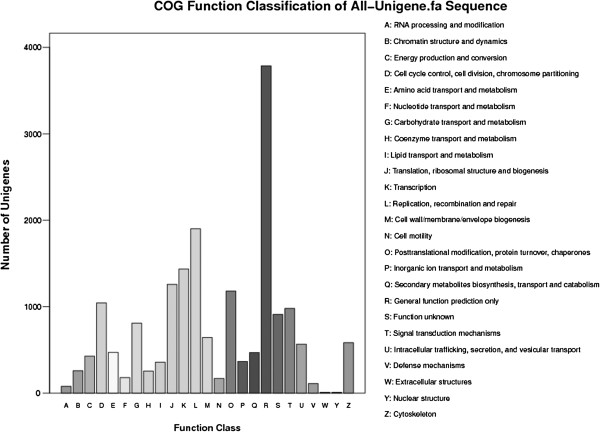
Histogram presentation of clusters of orthologous groups (COG) classification. Out of 39,228 nr hits, 9744 sequences have a COG classification among the 25 categories.